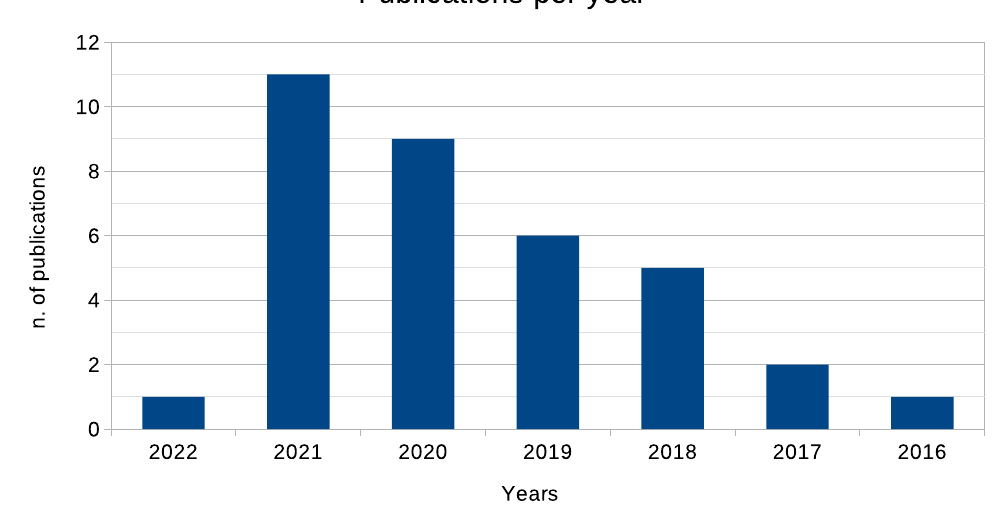
Figure 1. Number of the selected publications per year in the interval between 2016–2022. No relevant publications on video data augmentation has been found between 2012–2015.